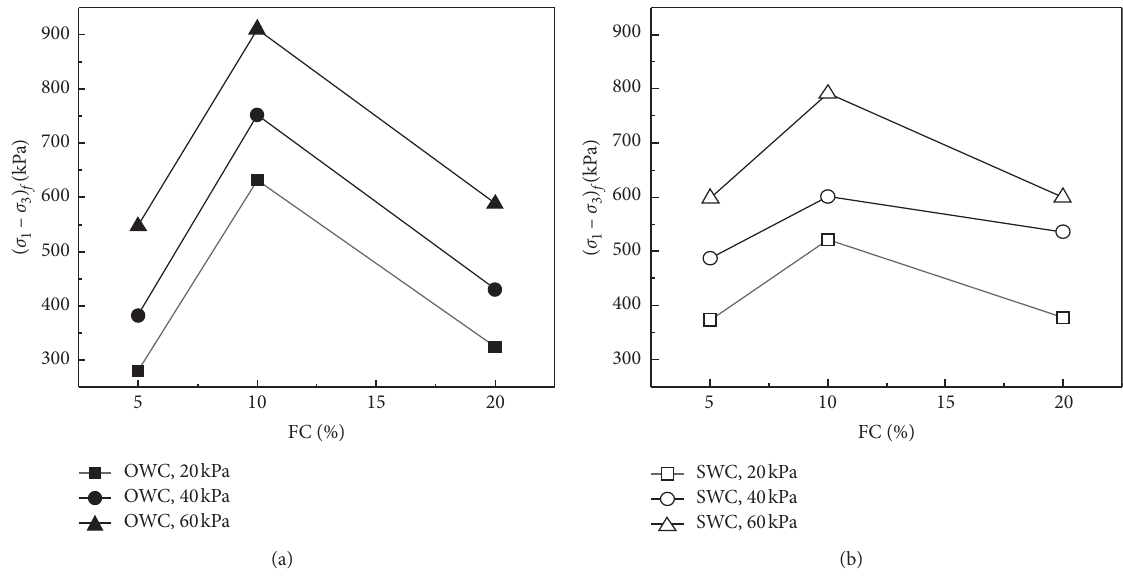
Figure 15: Relationship between FC and peak strength of graded gravels: (a) OWC samples; (b) SWC samples.